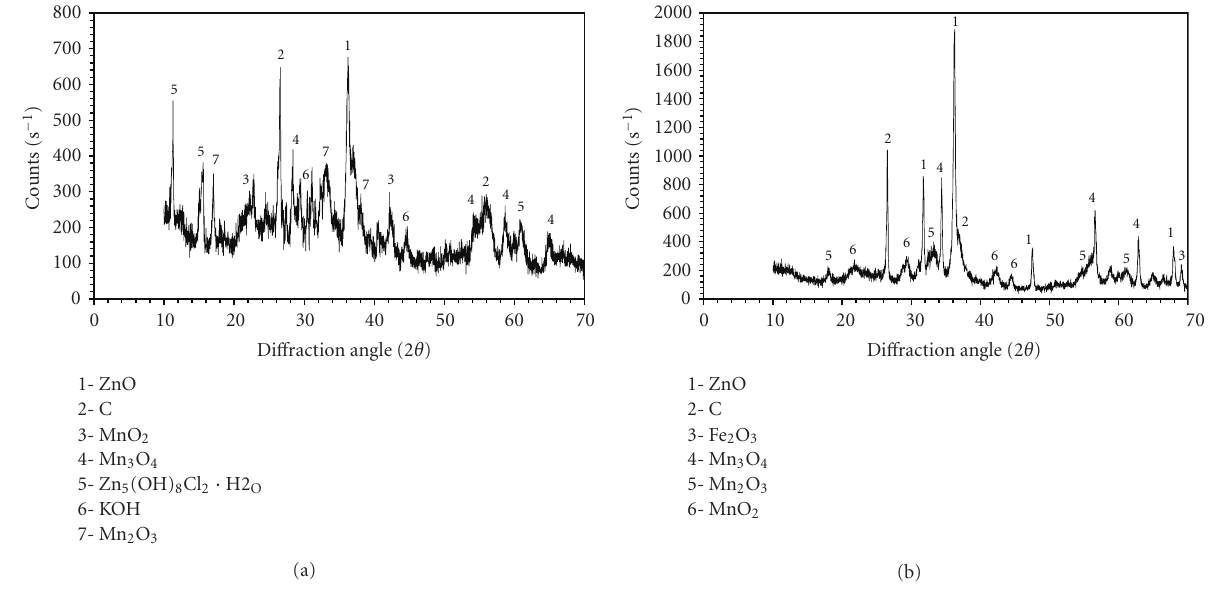
Figure 1: XRD pattern of original (a) and washed (b)